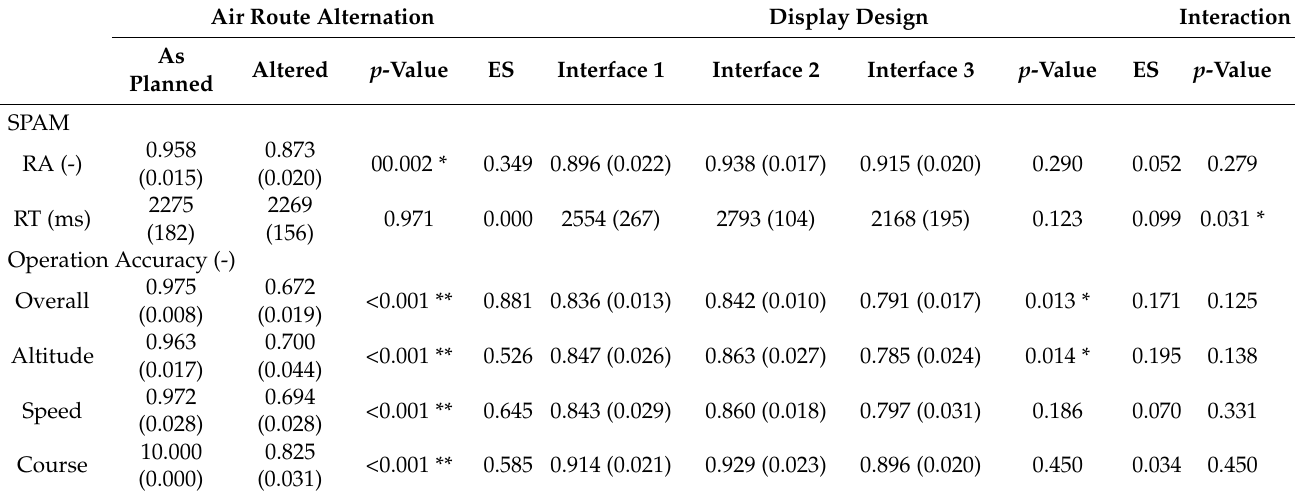
Table 2. ANOVA results for the SPAM response behavior and task performance (mean